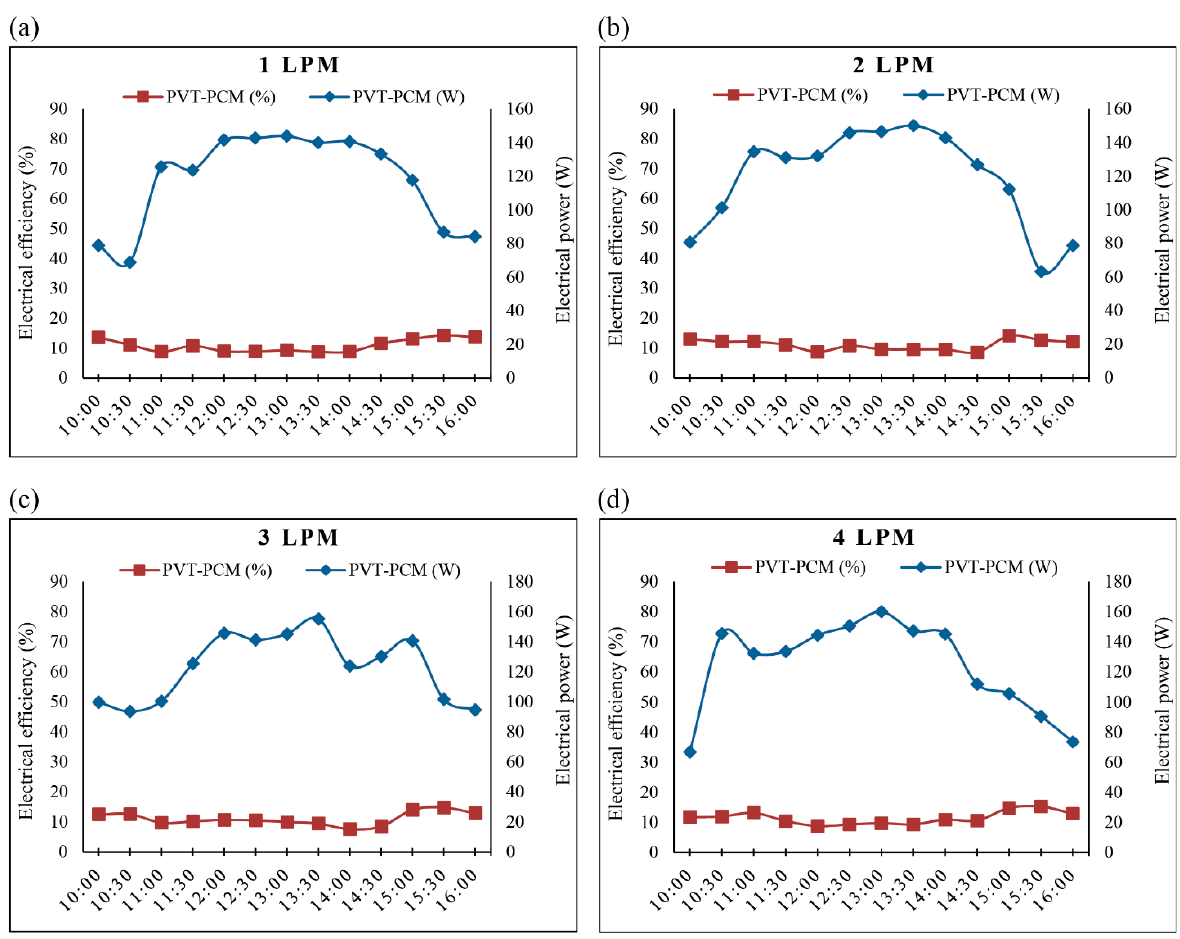
Figure 5. Electrical performance of PVT-PCM system at ( a ) 1 LPM, ( b ) 2 LPM, ( c ) 3 LPM, and ( d ) 4 LPM flow rate.